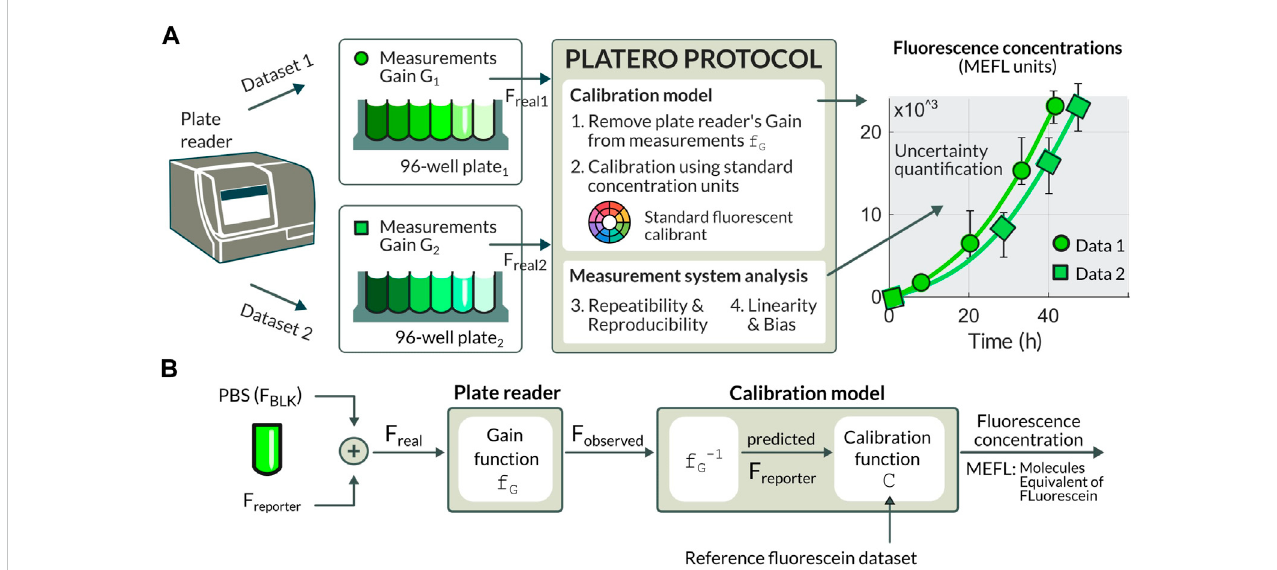
FIGURE 1 (A) The PLATERO calibration model brings the experimental measurements into a common gain-independent domain using standard concentration MELF units. The calibration protocol embeds a Measurement System Analysis providing estimation for the uncertainty that can be expected on the predicted concentrationvalue,andanassessmentoftheplatereaderbeingusedandthesourcesofuncertainty. (B) Diagramoftheproceduretoretrieveconcentration values from observed fl uorescence ( F observed ). The F observed values are a function ( f G )of the medium fl uorescence ( F BLK ), the fl uorescence of thereporter ( F reporter ), and the gain ( G ) at which fl uorescence values are measured. Once the gain and background effects are removed, the F reporter values are retrieved. The units conversion function ( f UC ) transforms these corrected fl uorescence values into standard concentration